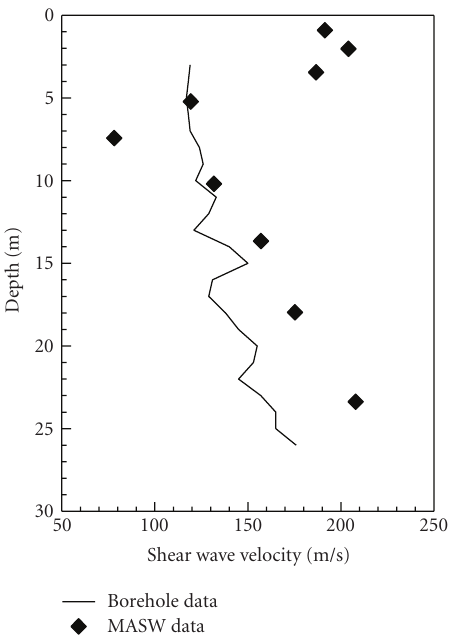
Figure 13: Dispersion curves of the fundamental mode and a higher mode (first mode) of the Rayleigh wave obtained from the combination of the active and remote passive MASW methods for the soccer field of Carleton